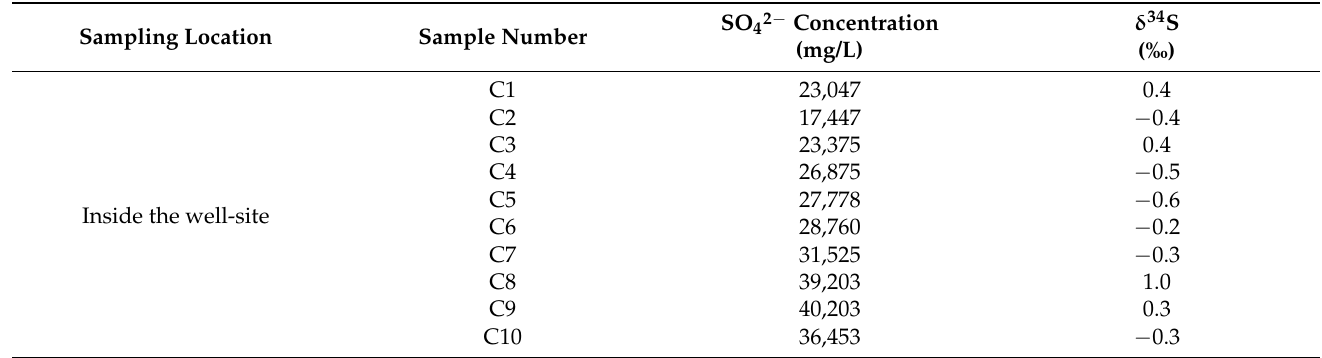
Table 3. SO 42 − concentration and sulfur isotopic composition of groundwater in and around an in-situ leaching well-site in